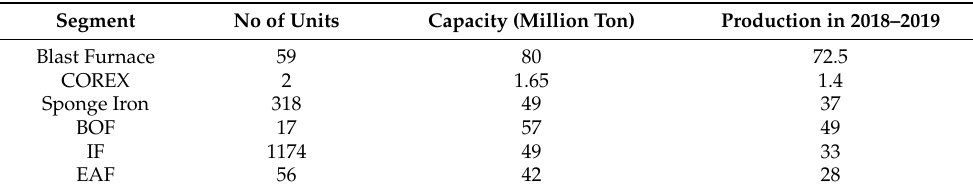
Figure 3. Indian steelmaking routes process map.